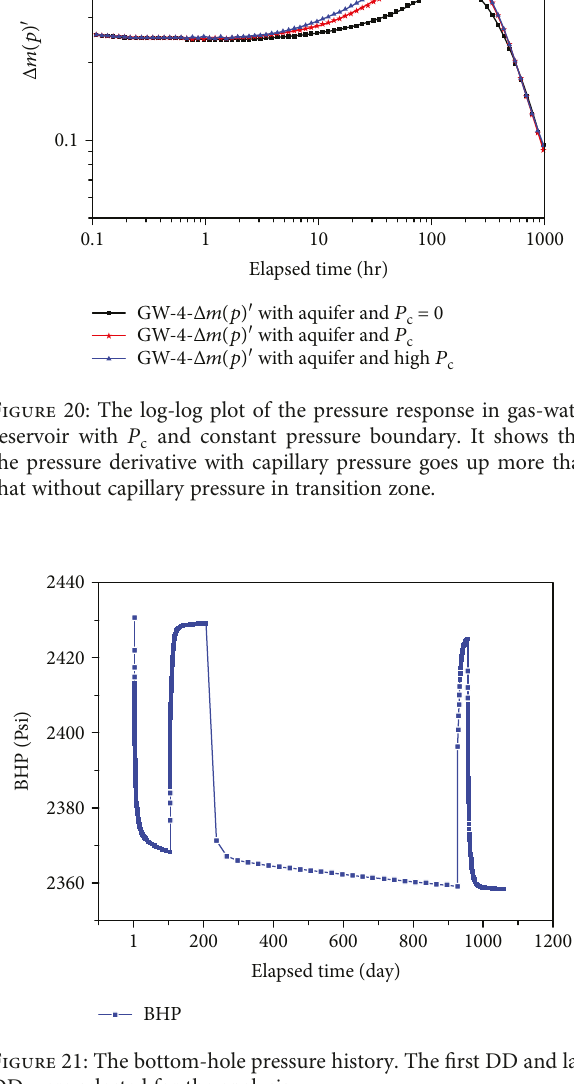
Figure 21: The bottom-hole pressure history. The fi rst DD and last DD were selected for the